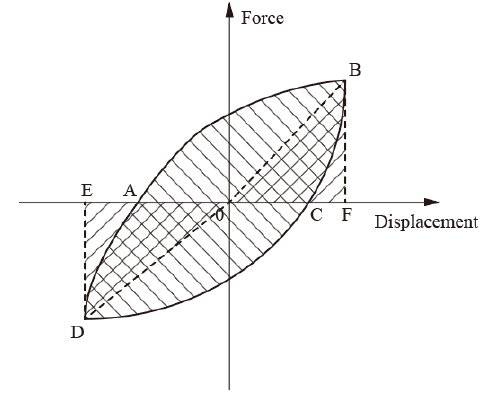
Figure 9. Hysteretic loop.